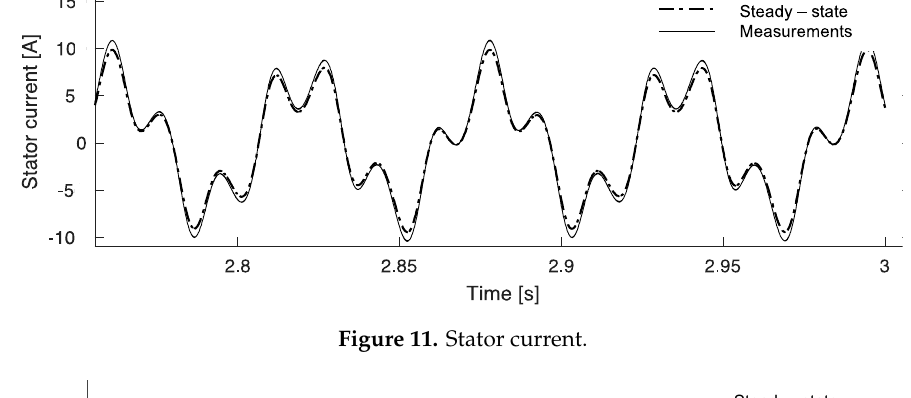
Figure 11. Stator current.